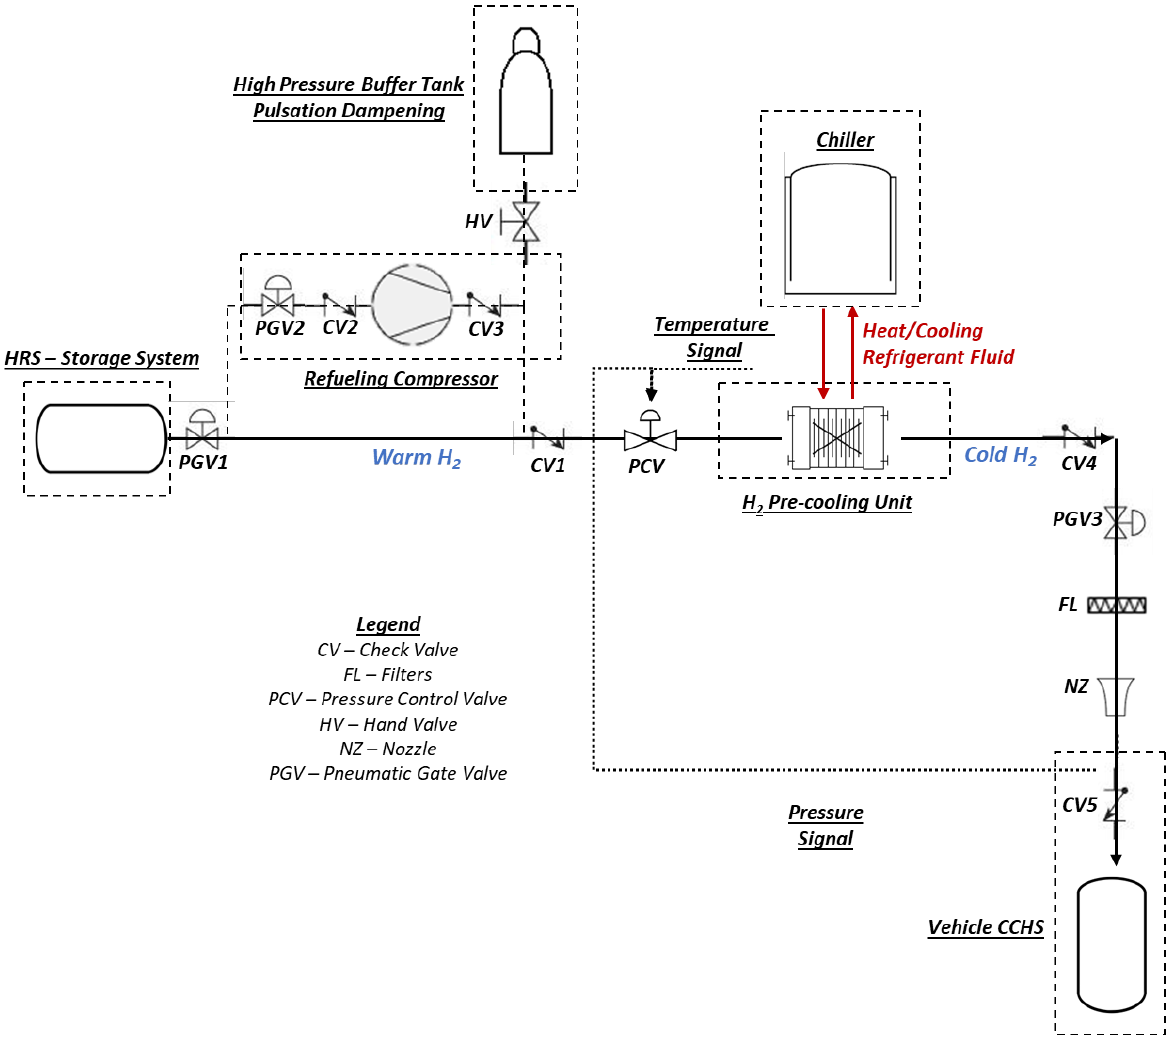
Figure 4. Concept of a schematized hydrogen refueling process.